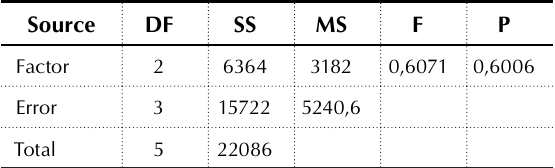
Table 6. ANOVA test